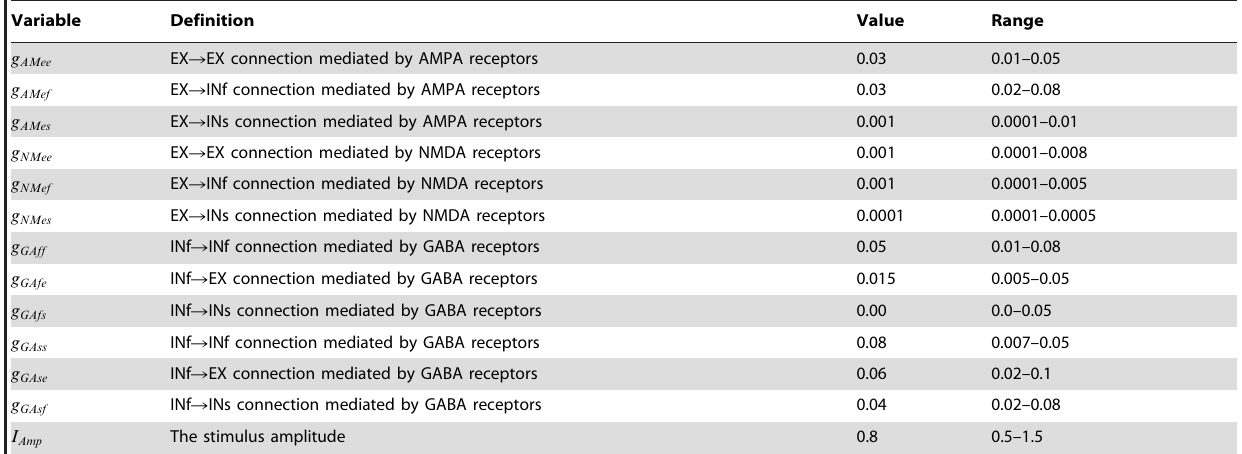
Table 1. Values of